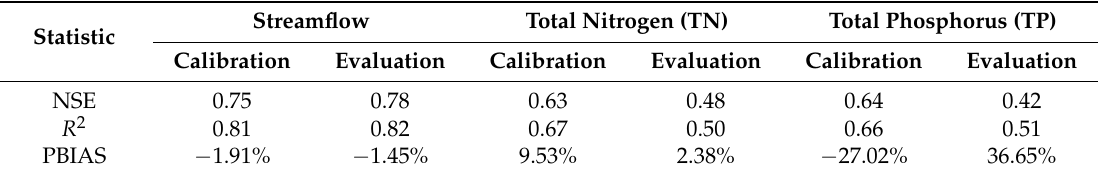
Figure 3. Simulated and measured monthly total nitrogen (TN) load at the outlet.